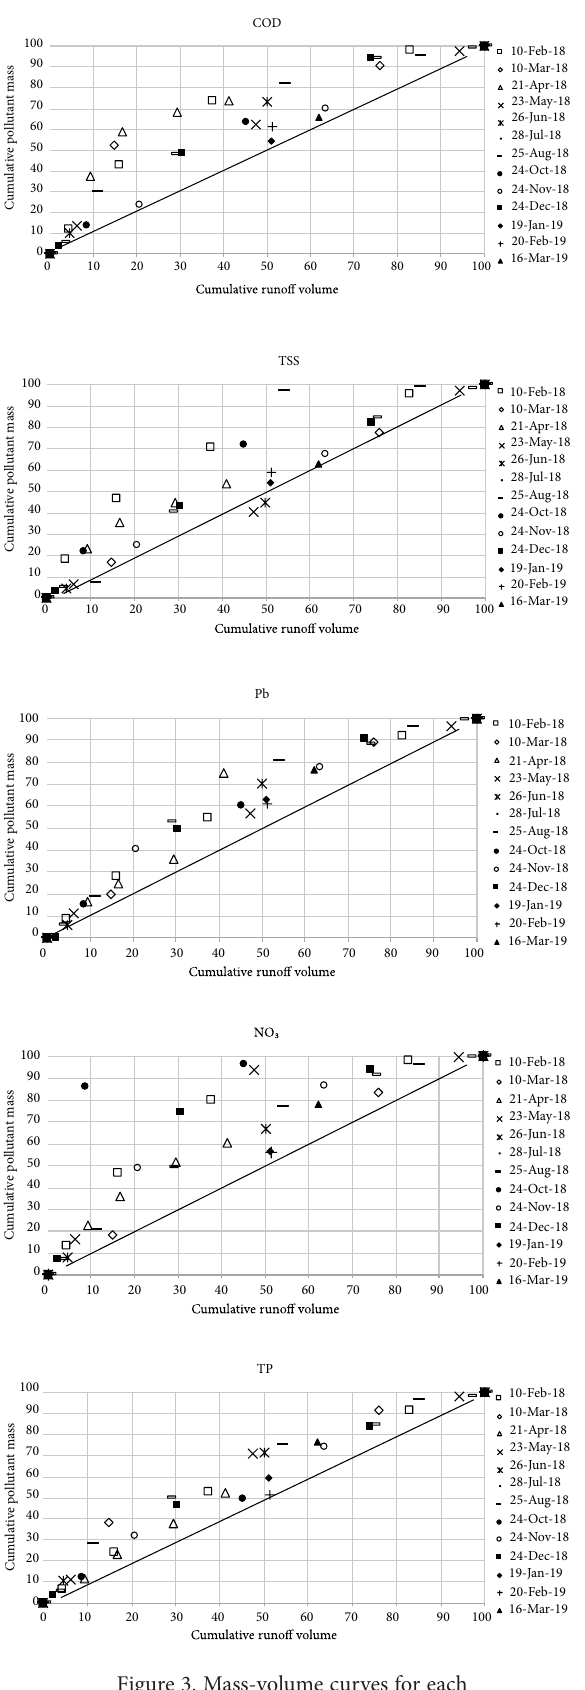
Figure 3. Mass-volume curves for each rainfall event